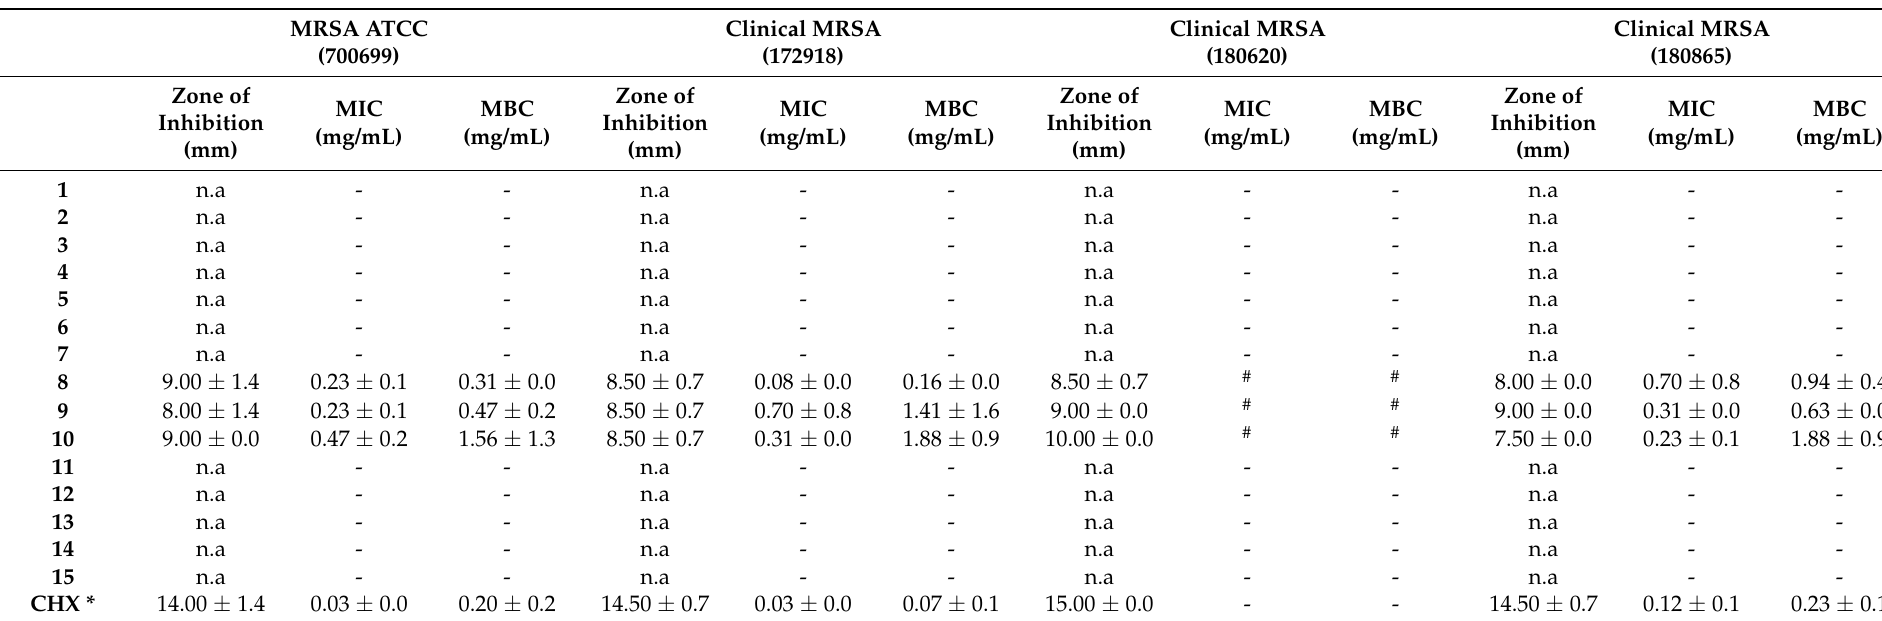
Table 1. In vitro anti-MRSA activity evaluation of pyrrolylated-chalcone analogues ( 1 – 15 ) against standard and clinical Staphylococcus aureus